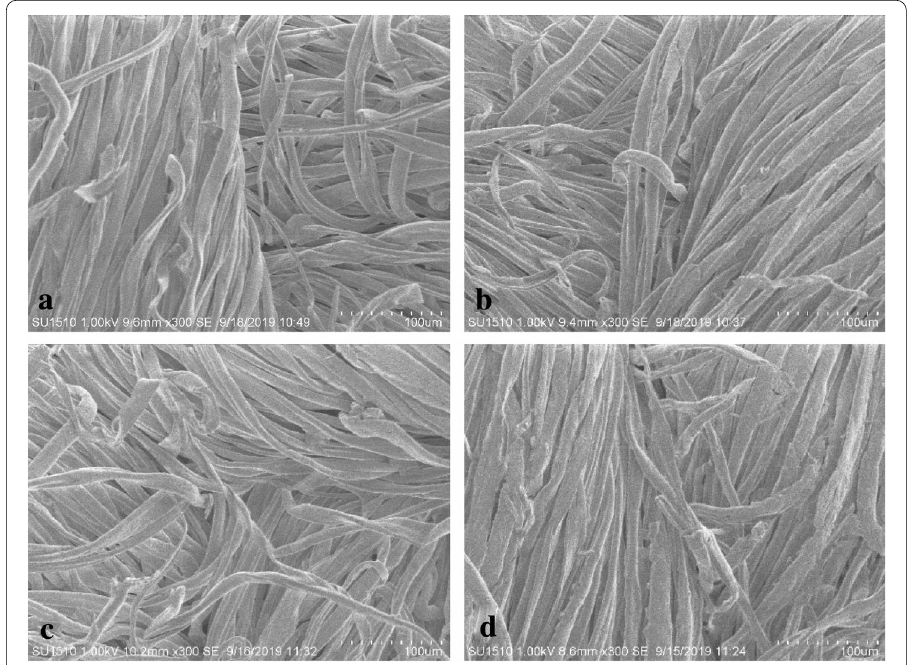
Fig. 8 Microscopic pictures of fibers from different washed samples at 300 SE a RFDC (Ready For Dyeing Canvas), b AD (After Dyeing), c AE (After Enzyme), d APN (After PP Followed by PP